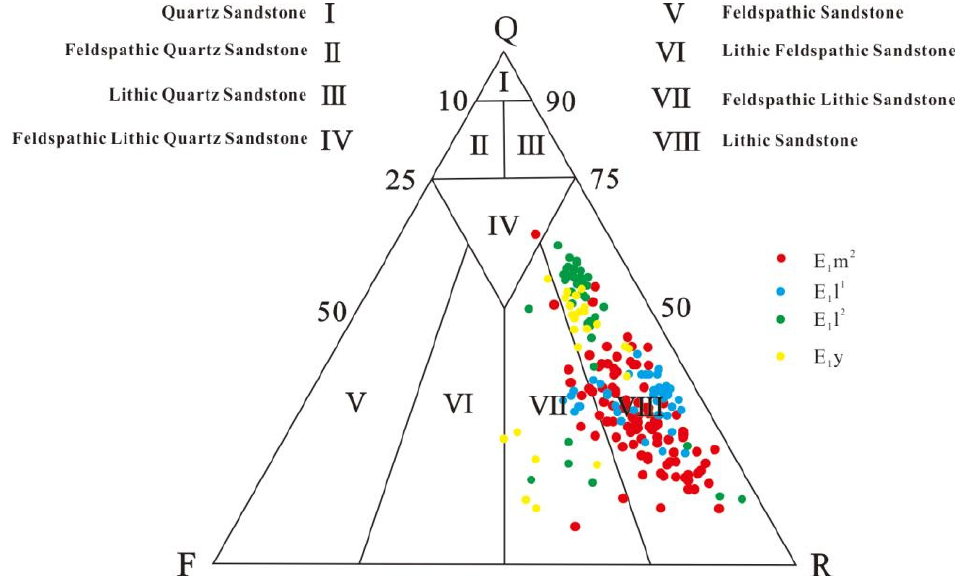
Figure 4. The composition triangle of the Paleocene sandstone in the West Lishui Sag [13,15].